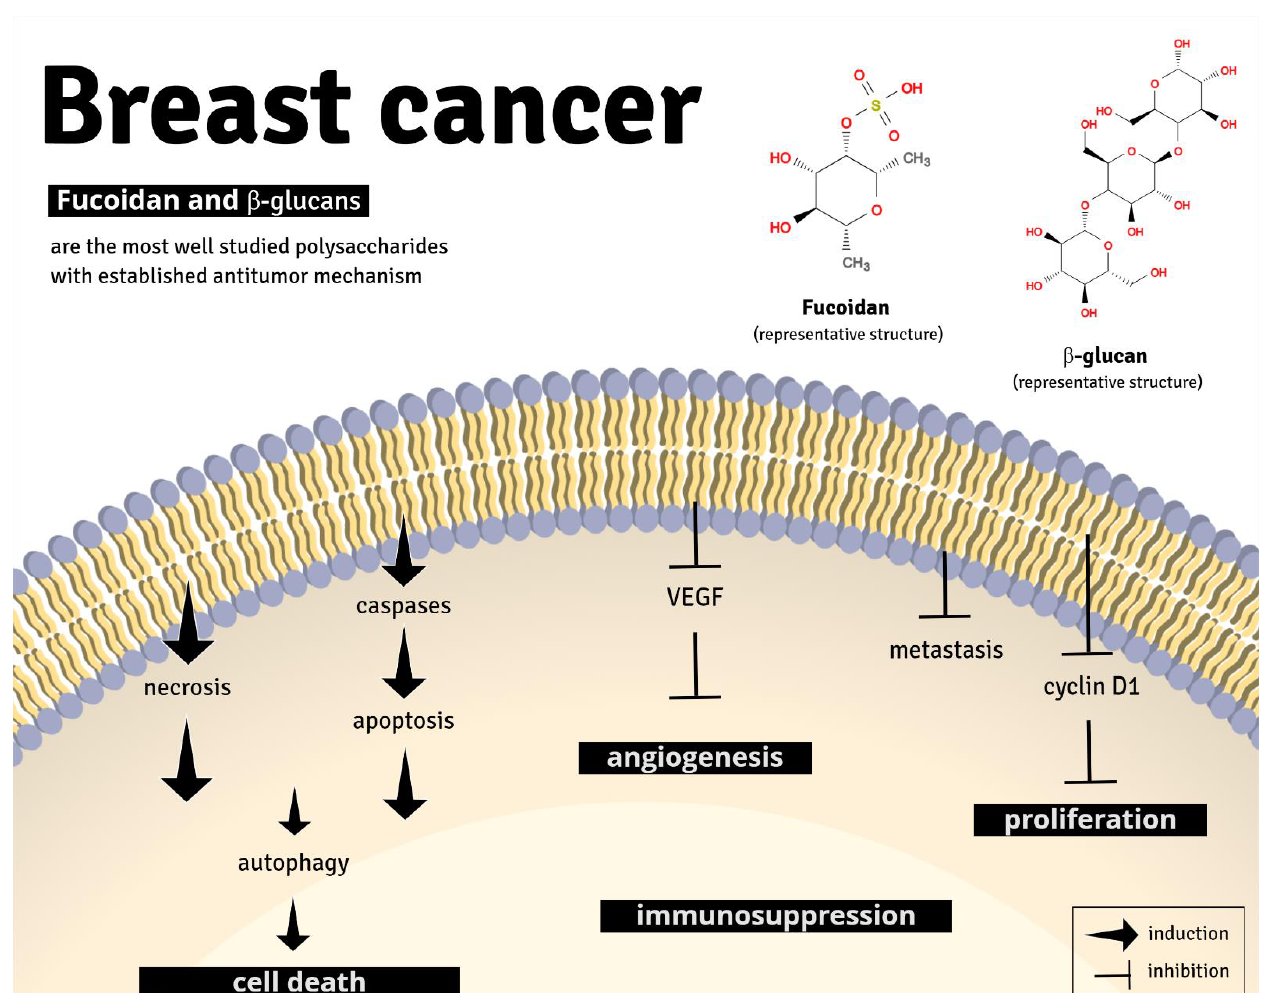
Figure 4. Representative image of the main anti-tumor pharmacological mechanism of fucoidan and β -glucans. Fucoidan and β -glucans can induce apoptosis, cell death, and immune suppression and inhibit angiogenesis, metastasis, and cell proliferation, through different signaling pathways (described in detail in Table 1).